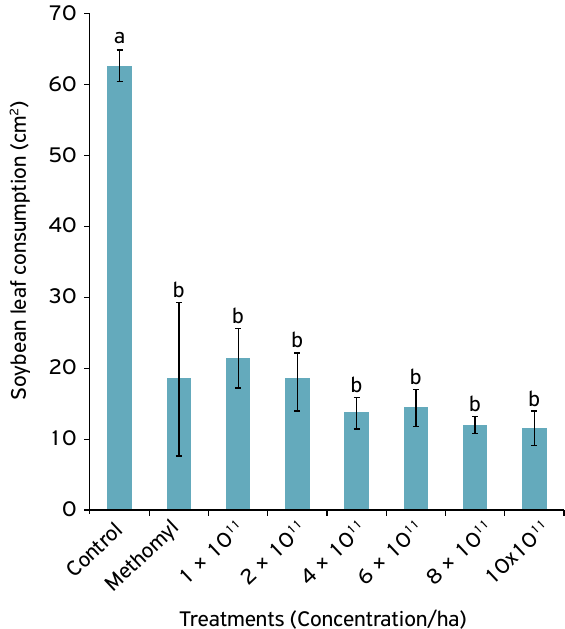
Figure 1. Average of total foliar consumption ( ± SE) of Chrysodeixis includens larvae (3 rd instar) after ingestion of soybean leaf discs either submerged or not (control) into six concentrations of isolate Chin-IA (I-A) (ChinNPV) and one dose of the chemical insecticide